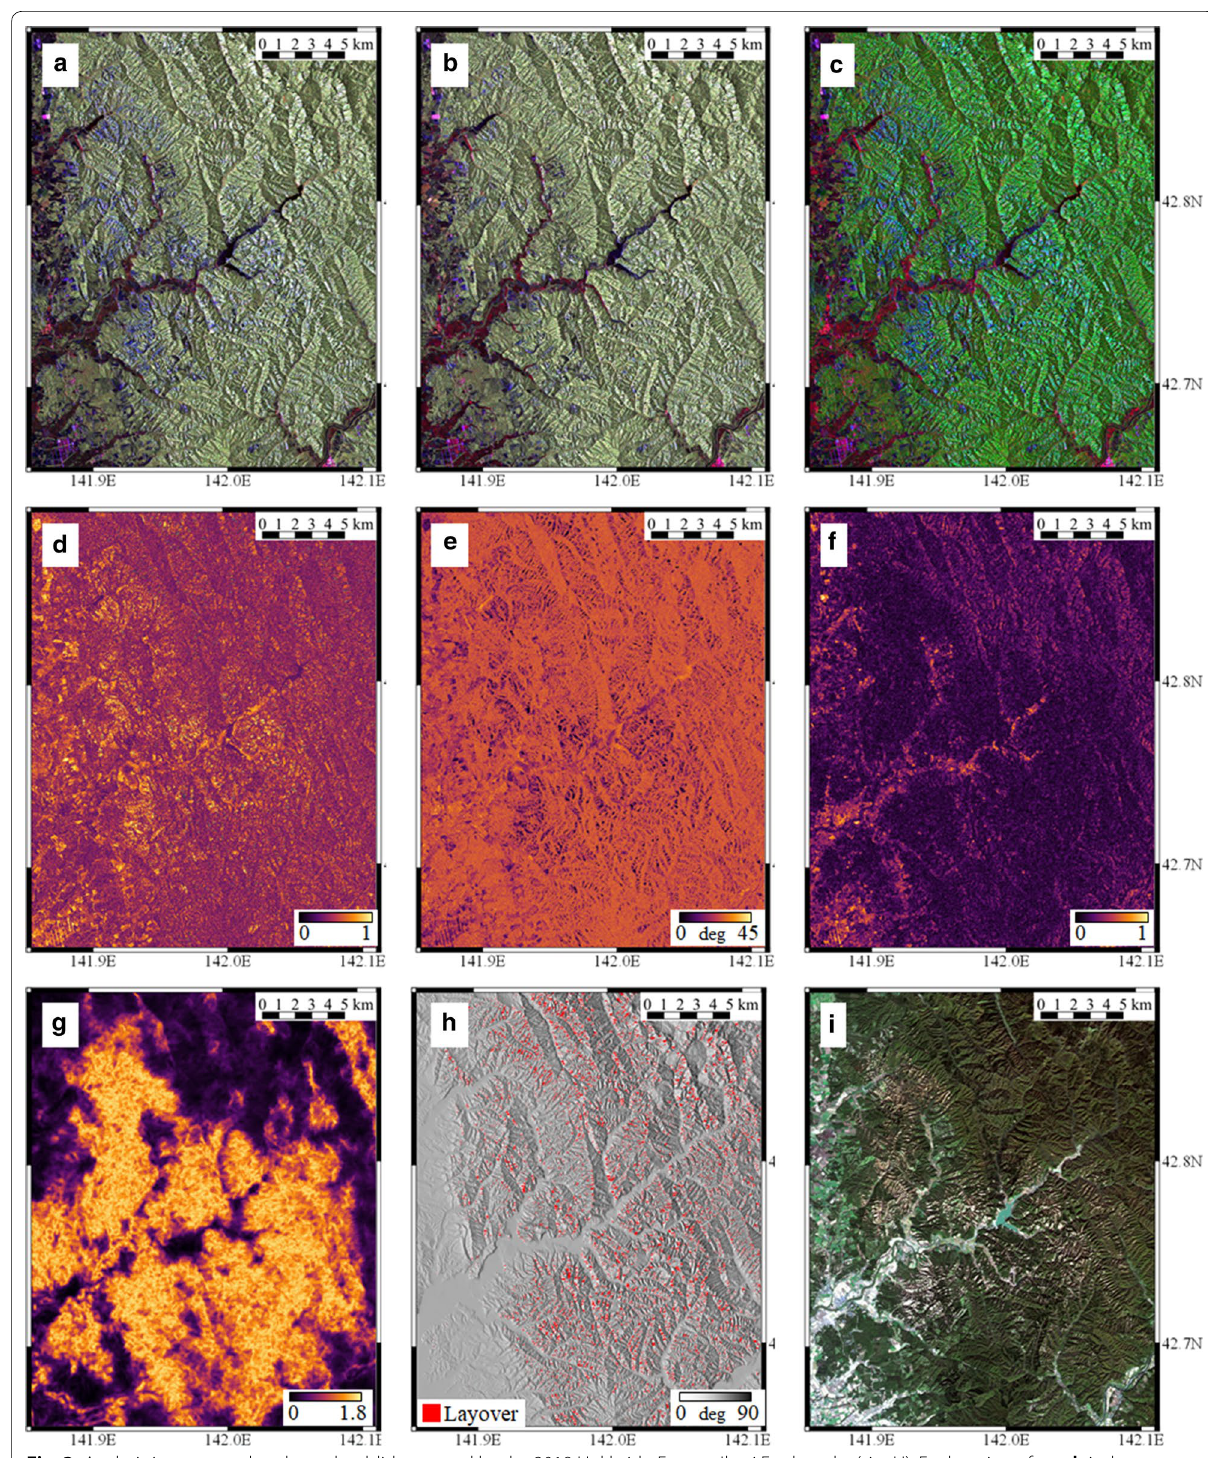
Fig. 3 Analysis images used to detect landslides caused by the 2018 Hokkaido Eastern Iburi Earthquake (site H). Explanation of a to h is the same as in Fig. 2. i An optical image by Sentinel-2 acquired on March 23,